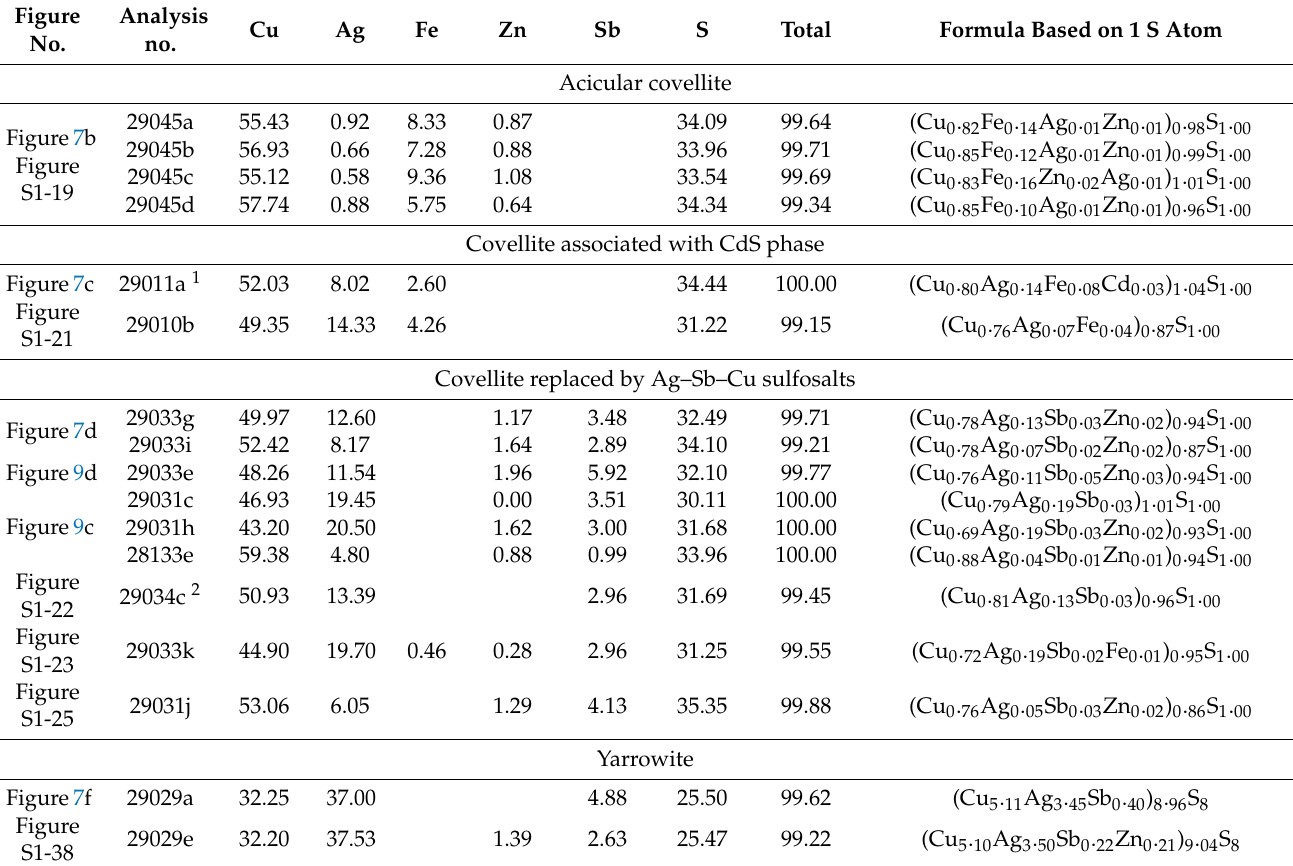
Table 4. Selected chemical composition of Cu sulfides from the Irinovskoe HSF,